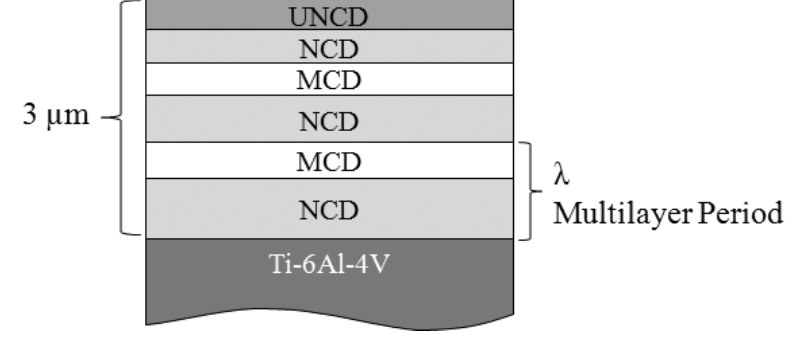
Figure 1. Schematic diagram of multilayered coating structure parameters in this